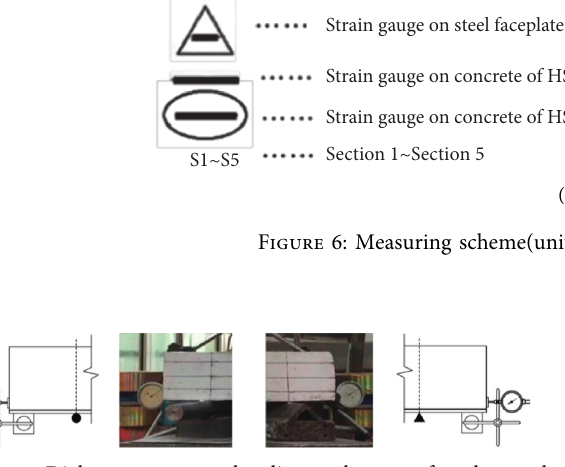
Figure 7: Dial gauges to test the slippage between faceplate and